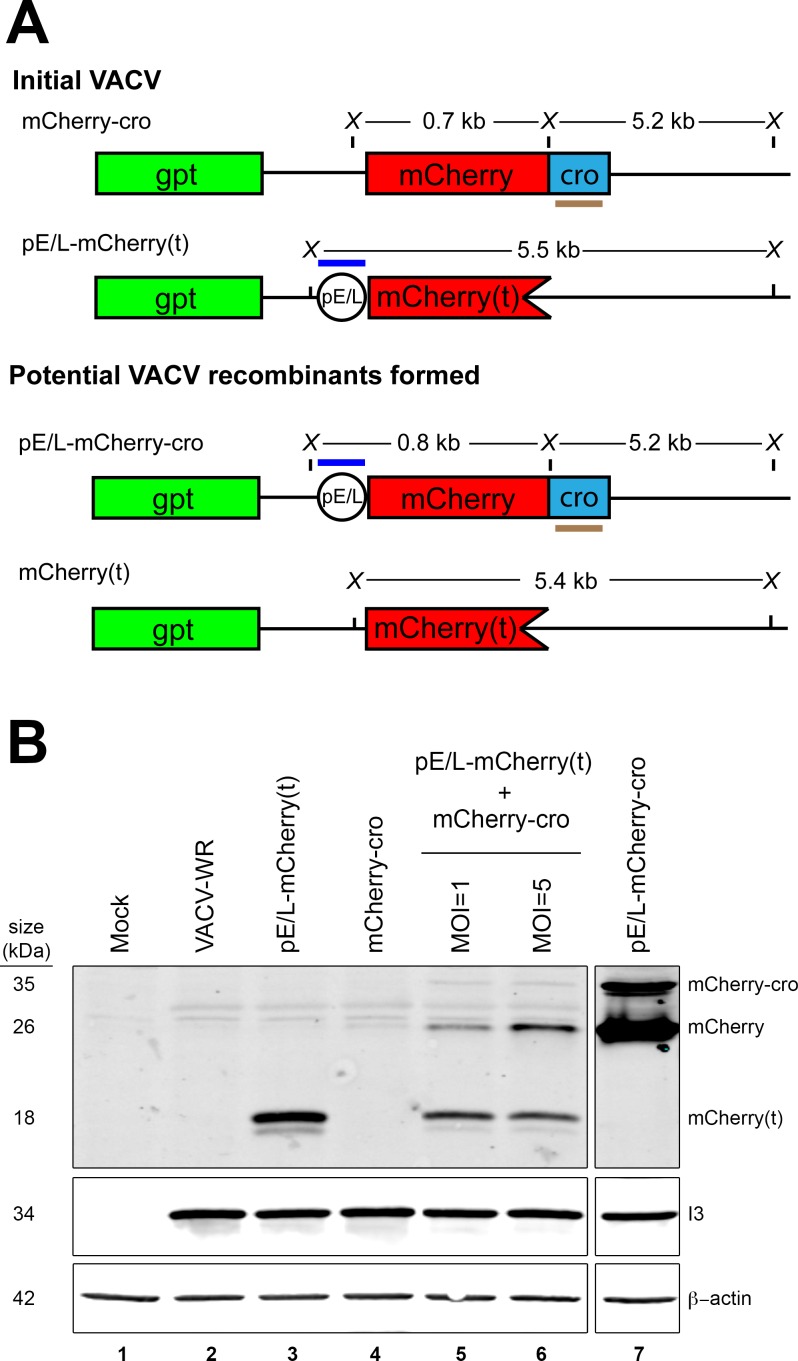
Quantifying the recombinants formed in co-infected cells.(A) The panel shows the two recombinant viruses that could be formed in cells co-infected with pE/L-mCherry(t) and mCherry-cro viruses. Also shown are the diagnostic restriction fragments that would be produced following XhoI digestion and the probes used for Southern blots (see Fig 8B). (B) Western blot analysis of proteins extracted from VACV-infected cells. BSC-40 cells were infected with the indicated viruses at a MOI = 5 (unless otherwise noted), harvested 24 h post-infection, and western blotted to detect recombinant mCherry-cro protein. A VACV gene product (I3) served as a marker of infection, and β-actin as a loading control. Note that both mCherry and mCherry-cro proteins are detected in cells infected with the control pE/L-mCherry-cro virus, suggesting that either could probably serve as a marker of recombination.